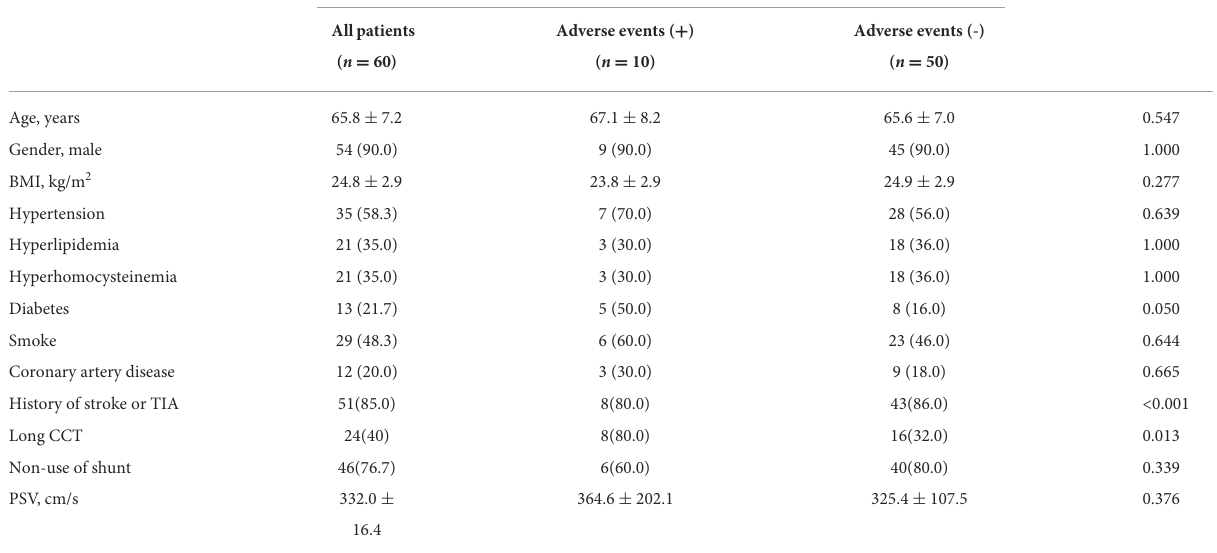
TABLE 1 Baseline clinical characteristics of the study population.